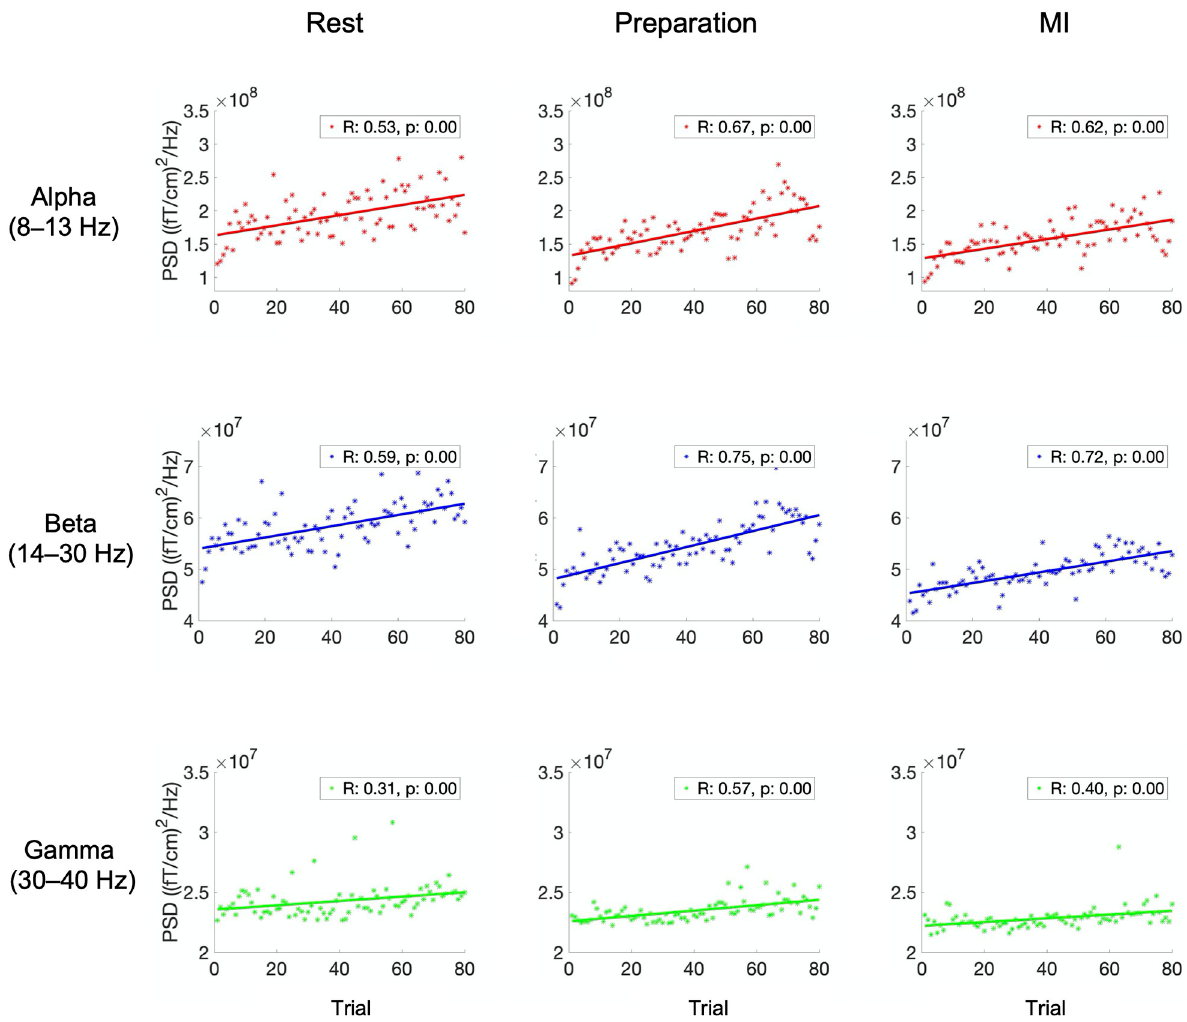
Fig 3. Alpha, beta, and gamma power over trials in Data 2. Power of alpha-, beta-, and gamma-band oscillations, averaged over all subjects and gradiometers, as a function of trial index when delivering proprioceptive feedback (Data 2). Correlation coefficient R and the corresponding p -value are shown in each